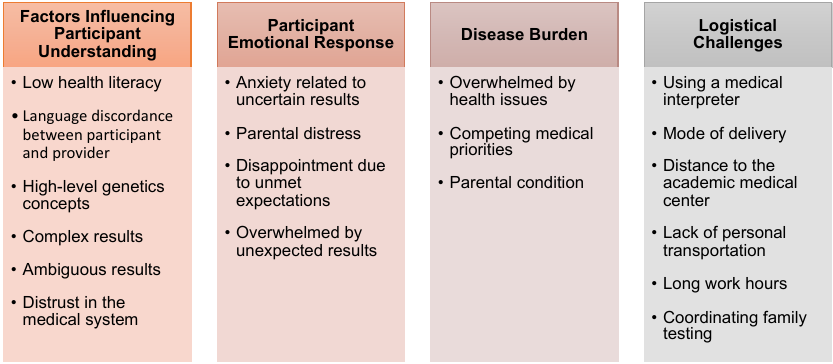
Figure 2. Categorized themes are highlighted in the case set.